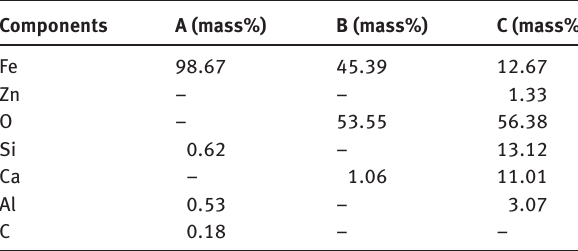
Table 7: The composition of minerals in the dust heated for 10 min (EDX)